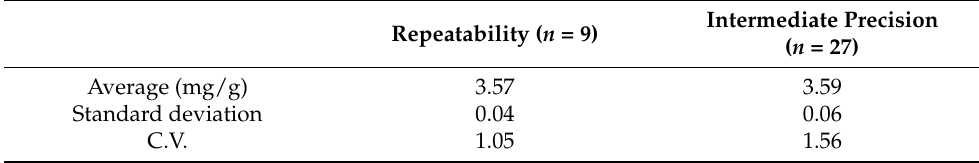
Table 3. Repeatability and intermediate precision of the developed